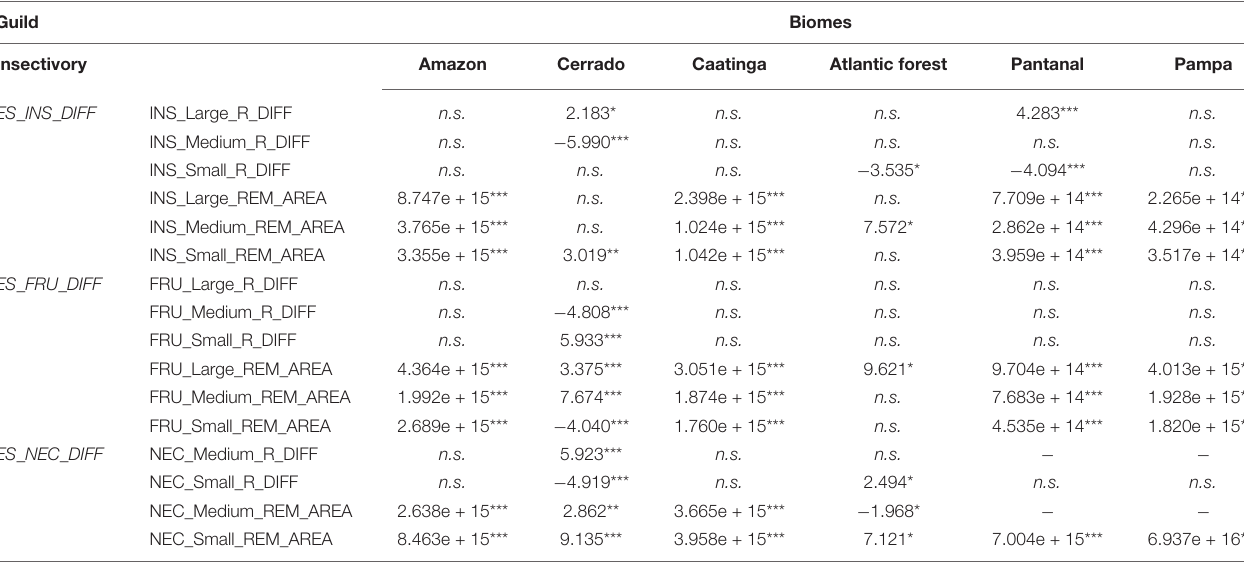
TABLE 6 | Results of the GLMs testing the effects of occurrence area reduction and of species loss on the ES index values after the incorporation of natural area suppression for the most speciose guilds.